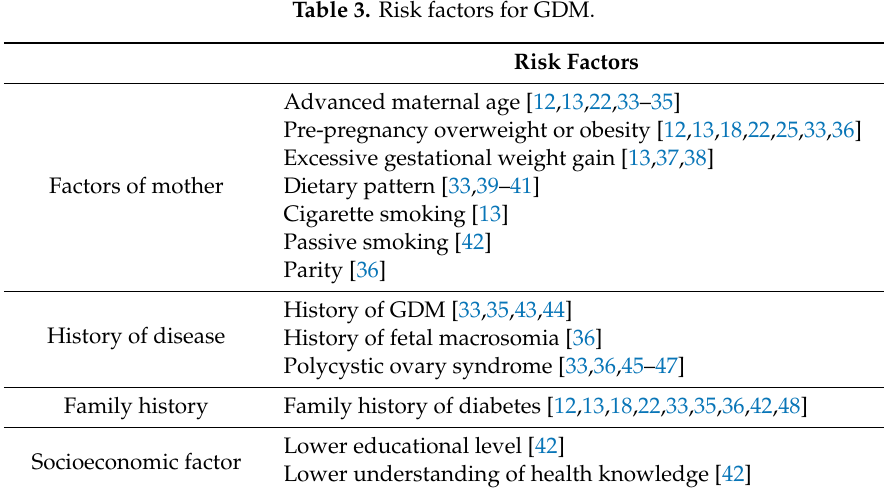
Diagnostic Criteria